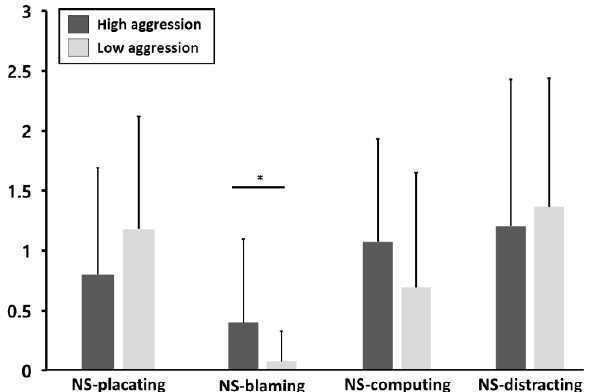
Figure 2. Comparison of the behavioral parameters obtained in the task of exploring the communica- tion style between participants with high aggression and low aggression. Standard deviations are represented as error bars. * p < 0.05.